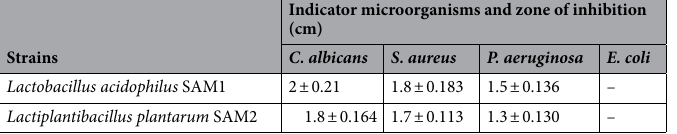
Table 1. Antimicrobial activity of the LAB strains.